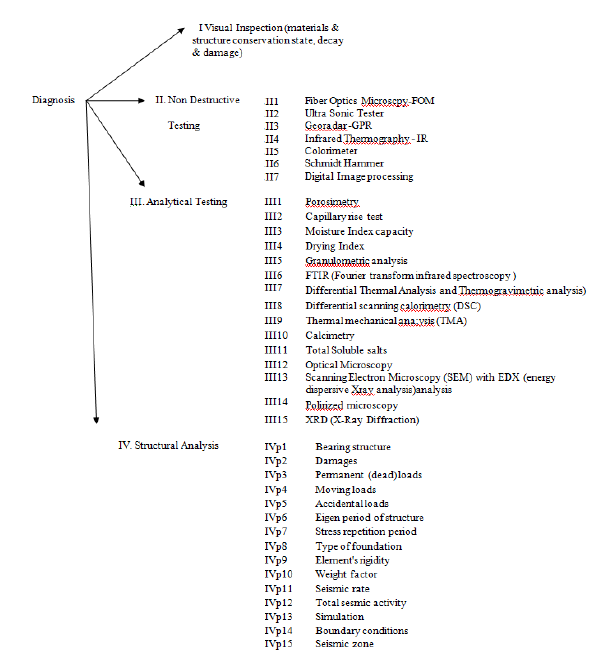
Figure 2. Integrated Protocols of Advanced Diagnostics data categories and